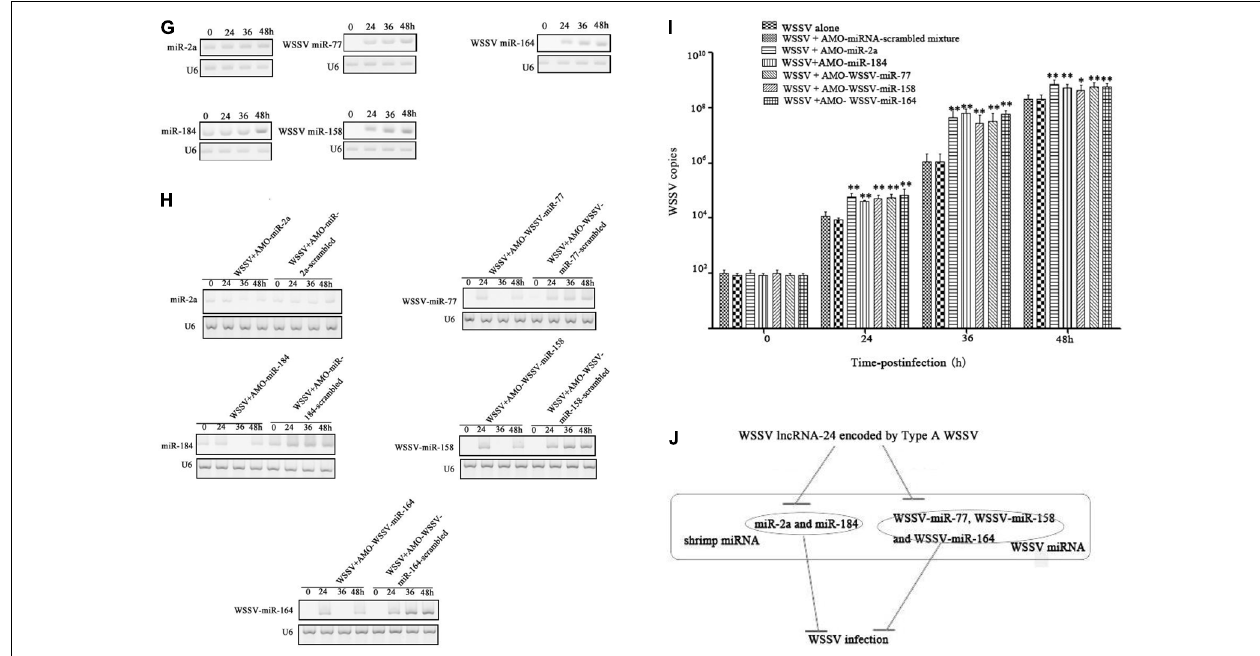
FIGURE 3 | Influence of Type A WSSV in the virus population on virus infection. (A) Silencing of WSSV lncRNA-24 encoded by Type A WSSV in WSSV-infected shrimp. Sequence-specific siRNA targeting WSSV lncRNA-24 and WSSV were coinjected into shrimp to knock down WSSV lncRNA-24. WSSV lncRNA-24-siRNA-scrambled was included in the injection as a control. At different time points post infection, the expression level of WSSV lncRNA-24 was examined using quantitative real-time PCR. (B) Effects of WSSV lncRNA-24 silencing on virus replication in shrimp. The WSSV copy numbers in shrimp treated with WSSV lncRNA-24-siRNA were quantified by real-time PCR. PBS, WSSV alone and WSSV lncRNA-24-siRNA-scrambled were used as controls. (C) Influence of WSSV lncRNA-24 silencing on shrimp mortality. The mortality of shrimp treated with WSSV lncRNA-24-siRNA was examined every day. The treatments are indicated at the top. (D) Prediction of miRNAs targeted by WSSV lncRNA-24. The seed sequences of miRNAs are underlined. (E) Direct interaction between WSSV lncRNA-24 and shrimp miR-2a, miR-9a or miR-184. Insect High Five cells were cotransfected with miR-2a, miR-9a or miR-184 and the plasmid EGFP-WSSV lncRNA-24 or EGFP- (cid:49) WSSV lncRNA-24. At 36 h after cotransfection, the fluorescence intensity of insect cells was evaluated. Scale bar, 50 µ m. (F) Interaction between WSSV lncRNA-24 and WSSV miRNAs. Insect High Five cells were cotransfected with a WSSV miRNA (WSSV-miR-158, WSSV-miR-77, WSSV-miR-212, or WSSV-miR-164) and the plasmid EGFP-WSSV lncRNA-24 or EGFP- (cid:49) WSSV lncRNA-24. At 36 h after cotransfection, the fluorescence intensity of insect cells was examined. Scale bar, 50 µ m. (G) Expression levels of miR-2a, miR-184, WSSV miR-77, WSSV miR-158, and WSSV miR-164 in virus-infected shrimp. Shrimp were challenged with WSSV. At different times post infection, the expression of miR-2a, miR-184, WSSV miR-77, WSSV miR-158, and WSSV miR-164 was detected in the haemocytes of virus-infected shrimp by Northern blot analysis. U6 was used as a control. The probes are indicated on the left. (H) Silencing of shrimp or WSSV miRNAs in WSSV-infected shrimp. Shrimp were coinjected with WSSV and AMO-miR-2a, AMO-miR-184, AMO-WSSV-miR-77, AMO-WSSV-miR-158, or AMO-WSSV-miR-164. AMO-miRNA-scrambled was included in the assays as a control. At different times post infection, the miRNA was detected by Northern blot analysis. The probes used are indicated on the left. The numbers show the time points post infection. U6 was used as a control. (I) Effects of shrimp or WSSV miRNA silencing on virus infection. WSSV and AMO-miRNA were coinjected into shrimp. A mixture of AMO-miR-2a-scrambled,